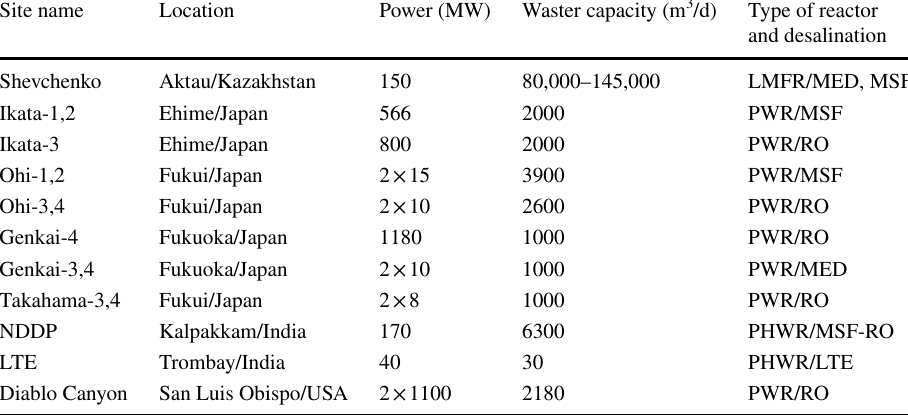
Fig. 22 The contribution of renewable energy resources in desalina- tion (Ayoub and Malaeb 2012) Table 10 Some of the world’s leading nuclear power desalination